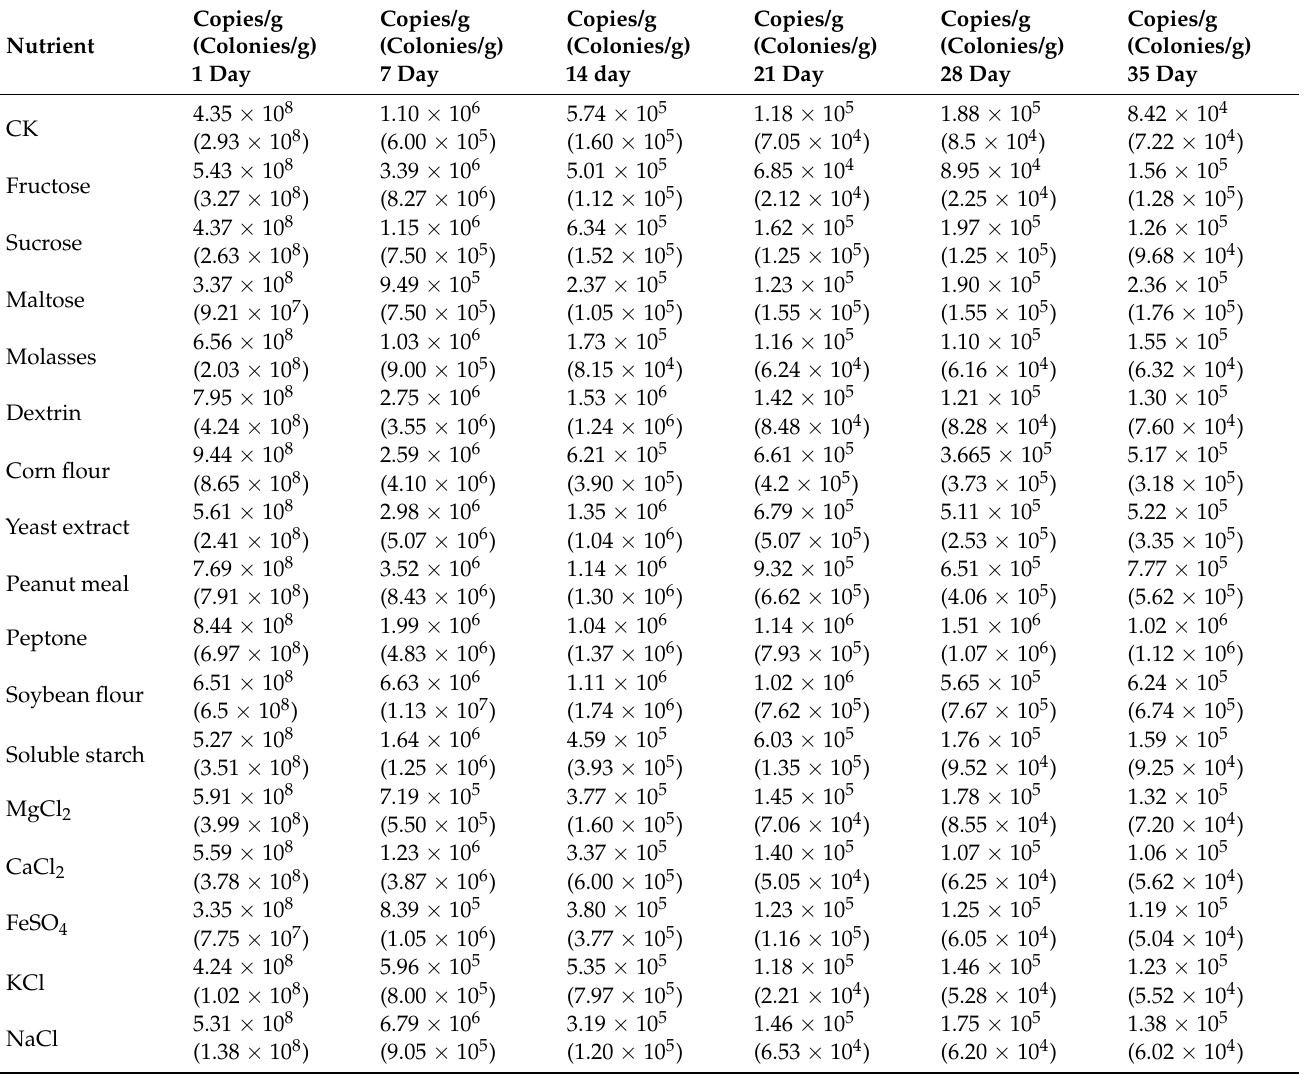
Table 6. The colonization abilities of strain ZF2 under different nutrient